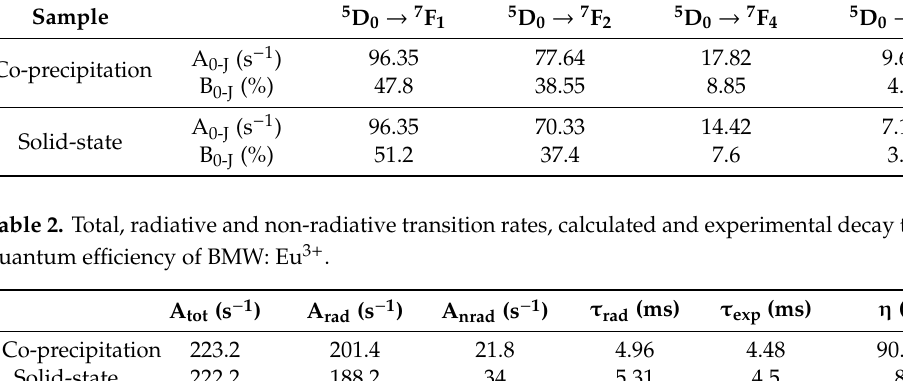
Table 3. The Judd–Ofelt Ω λ ( × 10 − 20 cm 2 ) parameters for Eu 3 + ions in various double perovskites.